Question: What kind of plot is shown here?
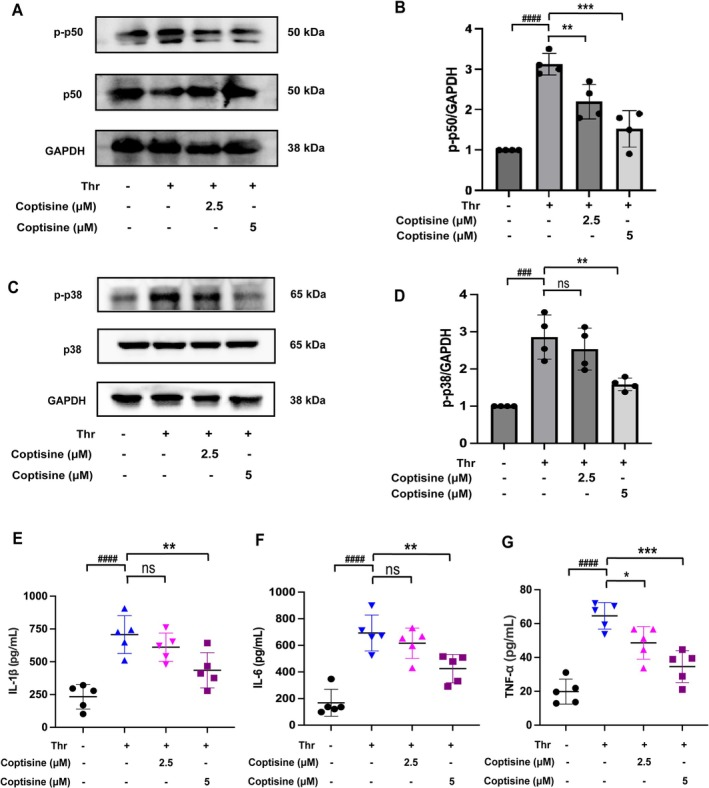
Answer: histogram